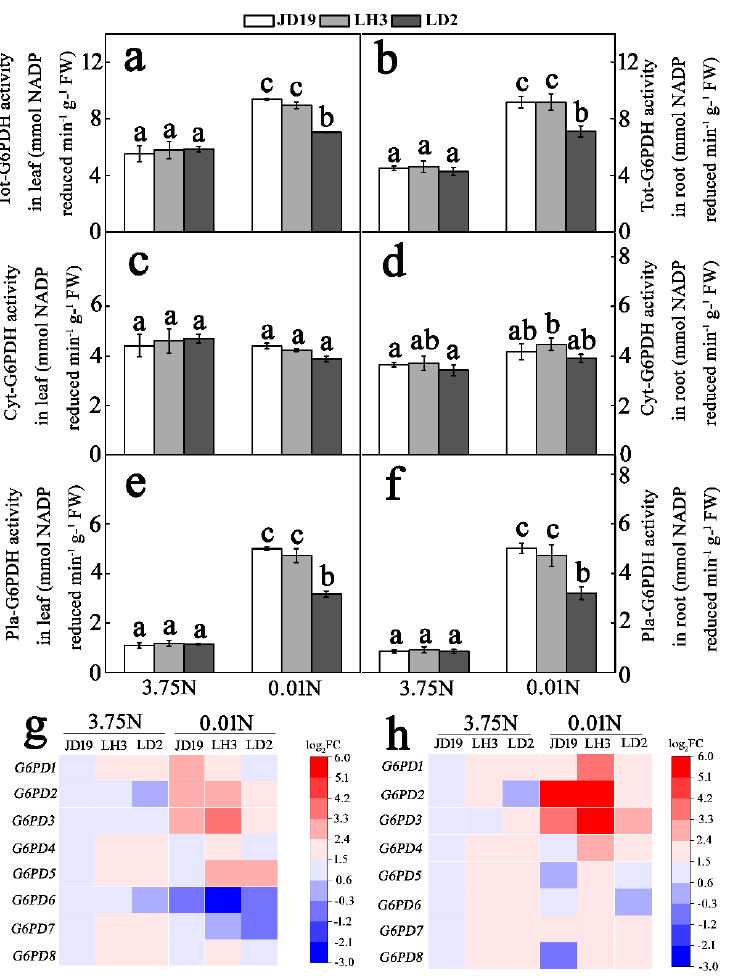
Figure 2. Effects of G6PDH activity and relative expression levels in three soybean cultivars under low-N stress. ( a ) Tot − G6PDH activity, ( c ) Cyt − G6PDH activity, ( e ) Pla − G6PDH activity in the leaves ( b ) Tot-G6PDH activity, ( d ) Cyt-G6PDH activity, ( f ) Pla-G6PDH activity in roots. Data are the means ± SE ( n = 3, p < 0.05). ( g ) relative expression levels of G6PDH in the leaves ( h ) relative expression levels of G6PDH in the roots. Data are means ± SE ( n = 3). The letters show significant differences under N conditions. 3.4. Low-N stress Increases ROS Levels after Dysfunction of G6PDH in Three Soybean Culti- vars